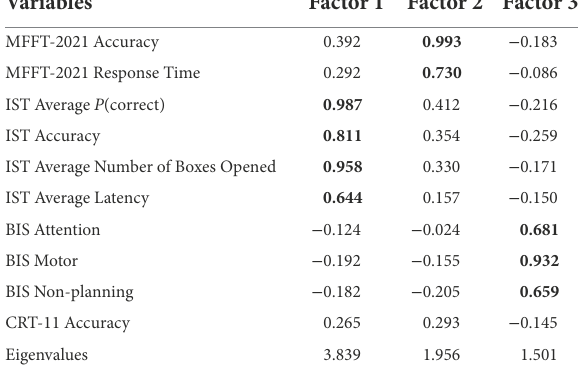
TABLE 7 Study 2 Factor loadings after Geomin oblique